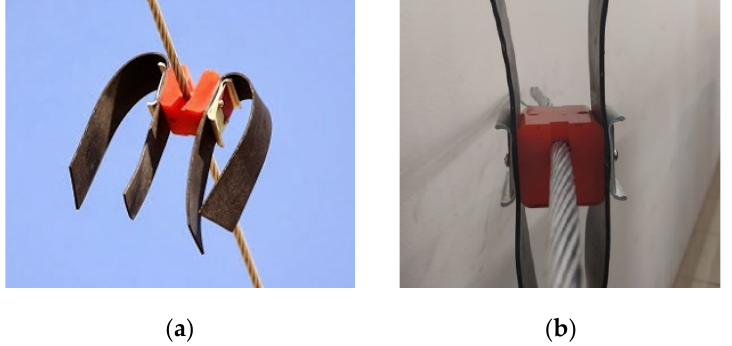
Figure 1. ( a ) Clip-type bird flight diverter developed by Wigeva currently installed on a power line cable; ( b ) detailed view of the diverter’s clip part (red) with the cable